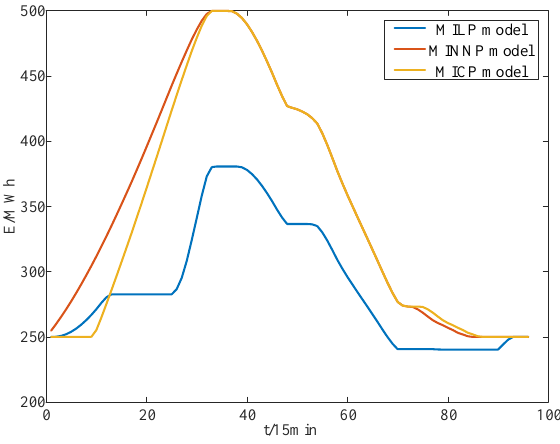
Figure 6. Stored energy schedule in the upper reservoir of PSH unit by three different SCUC models.